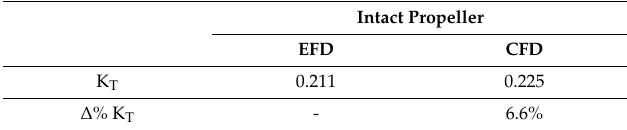
Table 5. Comparison of K T values for intact propeller between the EFD and computational fluid dynamics (CFD) results.